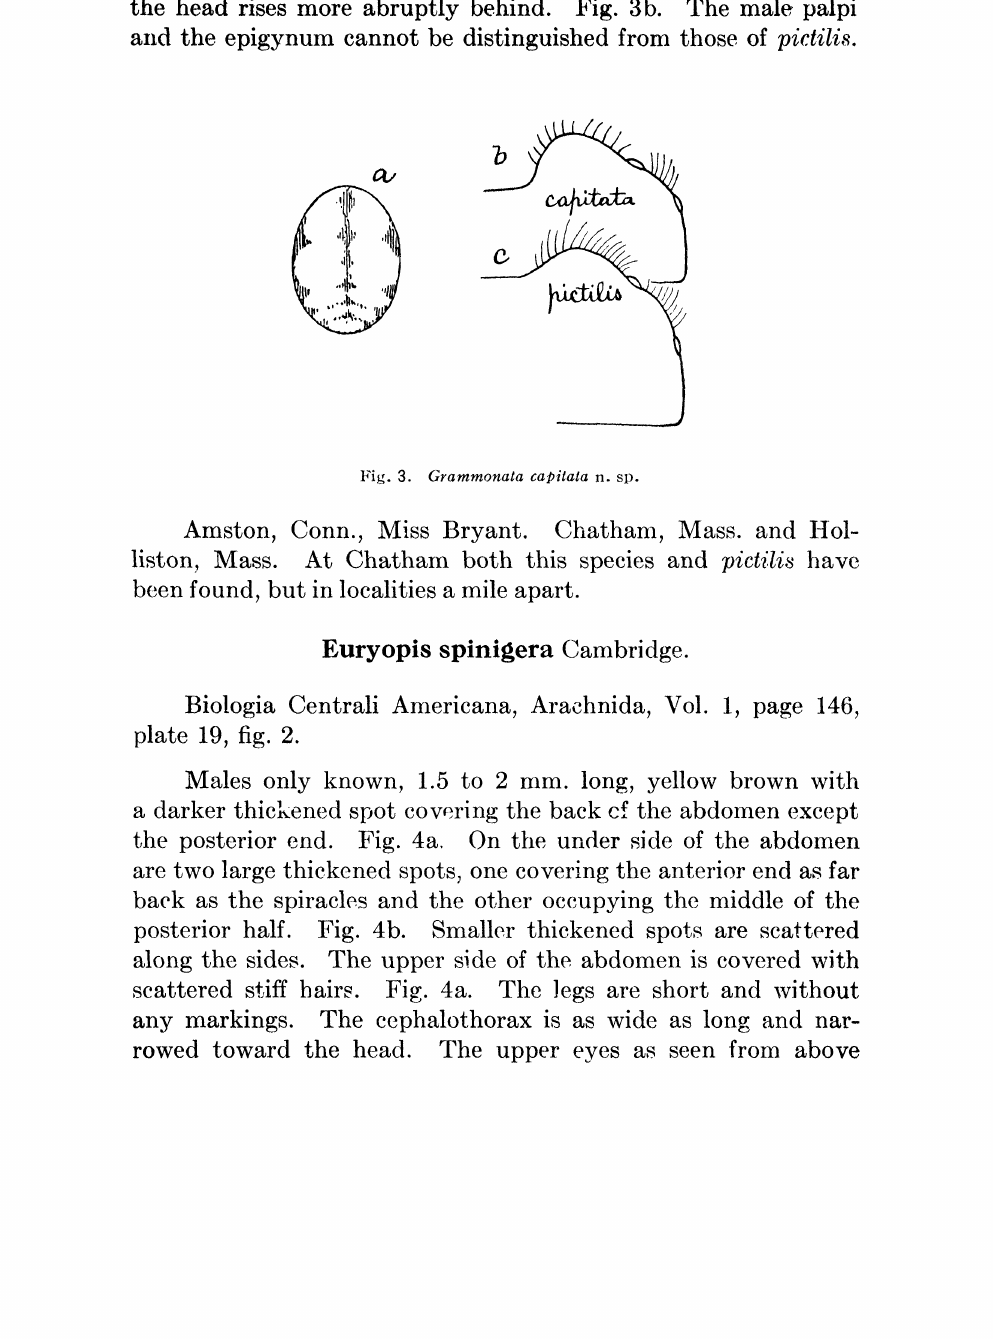
Fig. 3. Grammonata capitata sp.